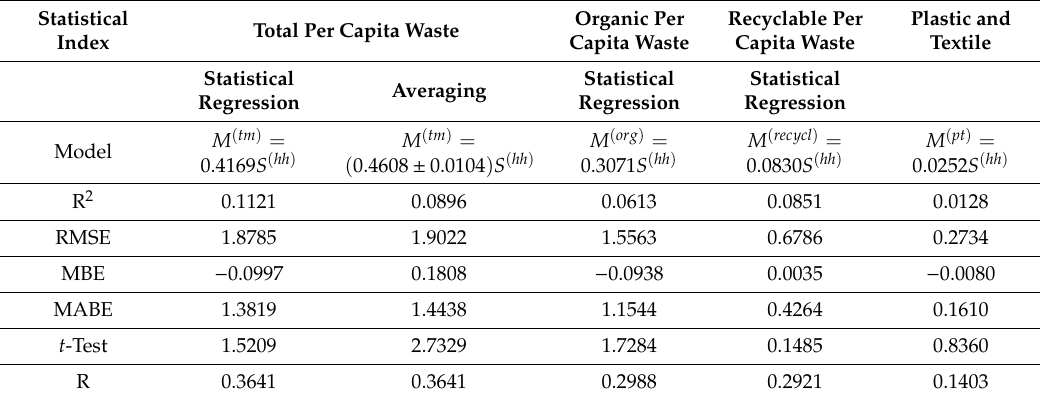
Table 6. The statistical indices of the regression and averaged models of per capita household MSW.